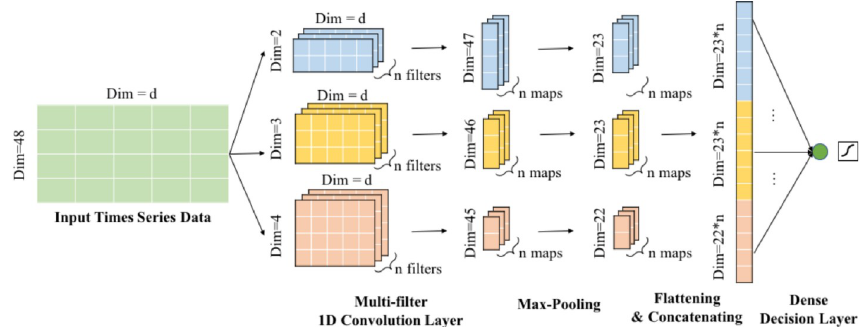
Fig 2. The 1D multi-filter convolutional neural network. We conduct the convolution on the time axis with 48-hour time window and D dimension using filter size 2, 3 or 4 accordingly. The computed feature maps are finally concatenated and fully connected to a dense decision layer with one output